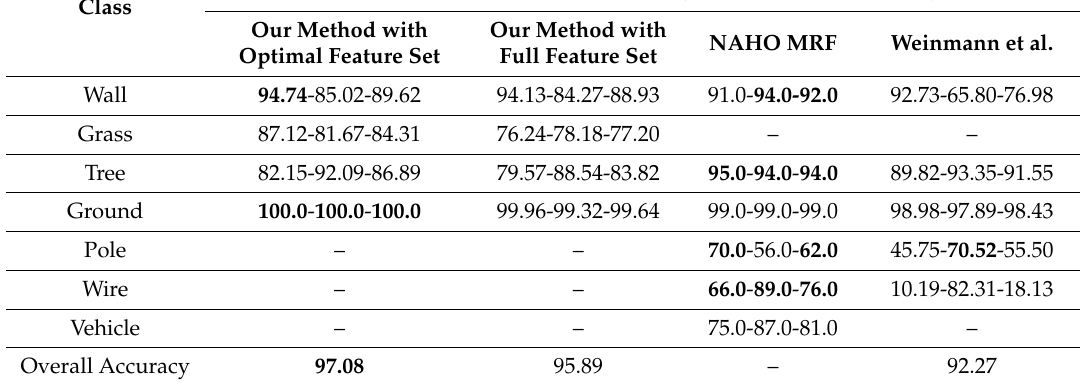
Table 4. Evaluations of point cloud classifications of the Oakland dataset by different methods. All values are in percentage (– indicates the value is not provided or has no meaning). NAHO MRF —non-associative higher-order Markov